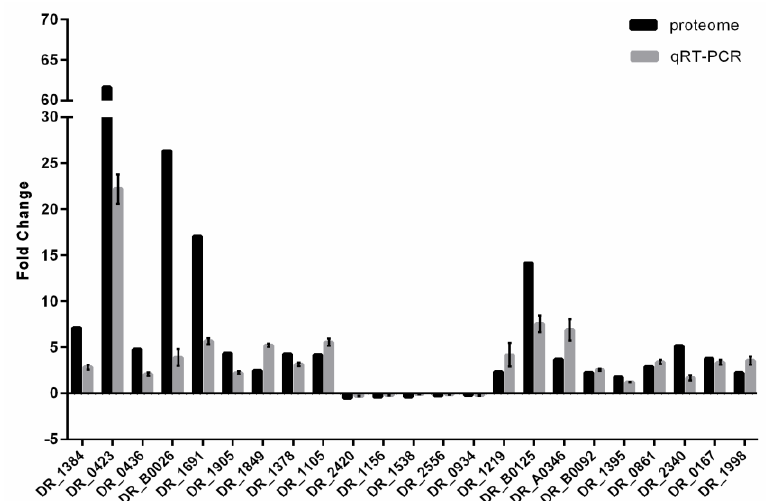
Figure 3. Comparison of the fold change in expression levels of differential proteins detected by Proteomic and Quantitative Real-Time PCR (qRT-PCR). The qRT-PCR data are presented as the mean ± SD values of triplicate reactions for each gene transcript. The selected proteins belong to different functional categories; the annotation of each gene is detailed in Supplementary Table S1.